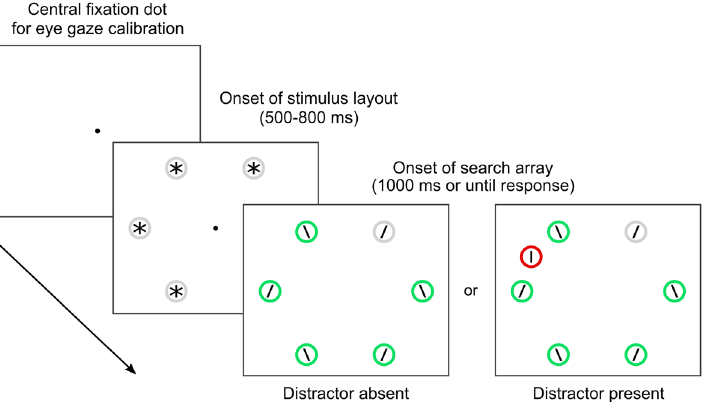
Figure 1. Experimental task and stimuli. Each trial started with a central fixation dot which also served for calibration of eye gaze, then the stimulus layout appeared, which was replaced after a variable time by the search array. The target stimulus in the search array was defined by the circle which remained gray, as opposed to the others which turned green. In a proportion of trials an additional stimulus appeared in a previously empty location, which was irrelevant to the task and acted as a salient